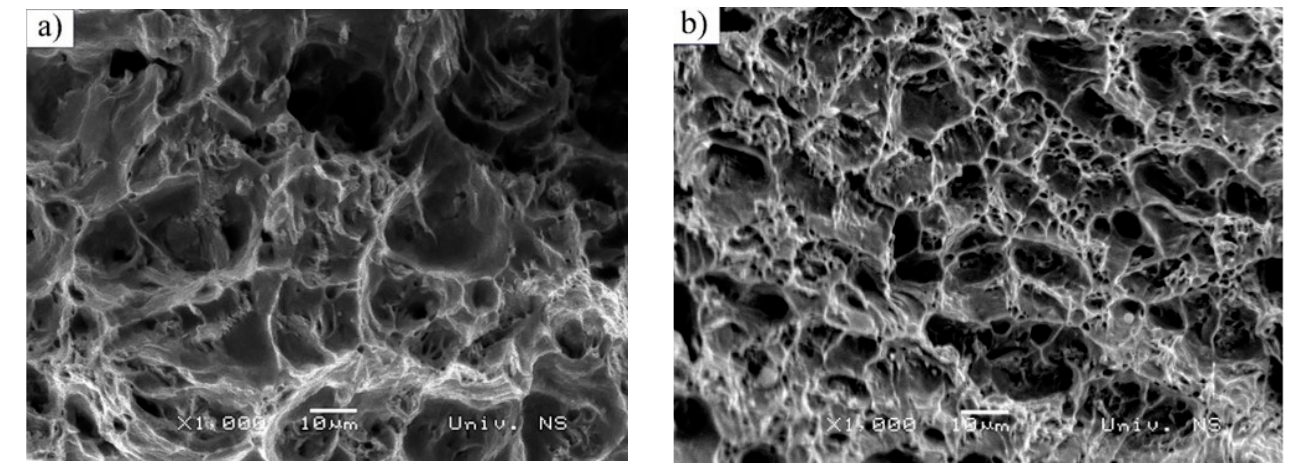
Figure 8. Final fracture zone in tested steels-image taken using SEM microscope: ( a ) S235JRC+C steel and ( b ) C15E+C